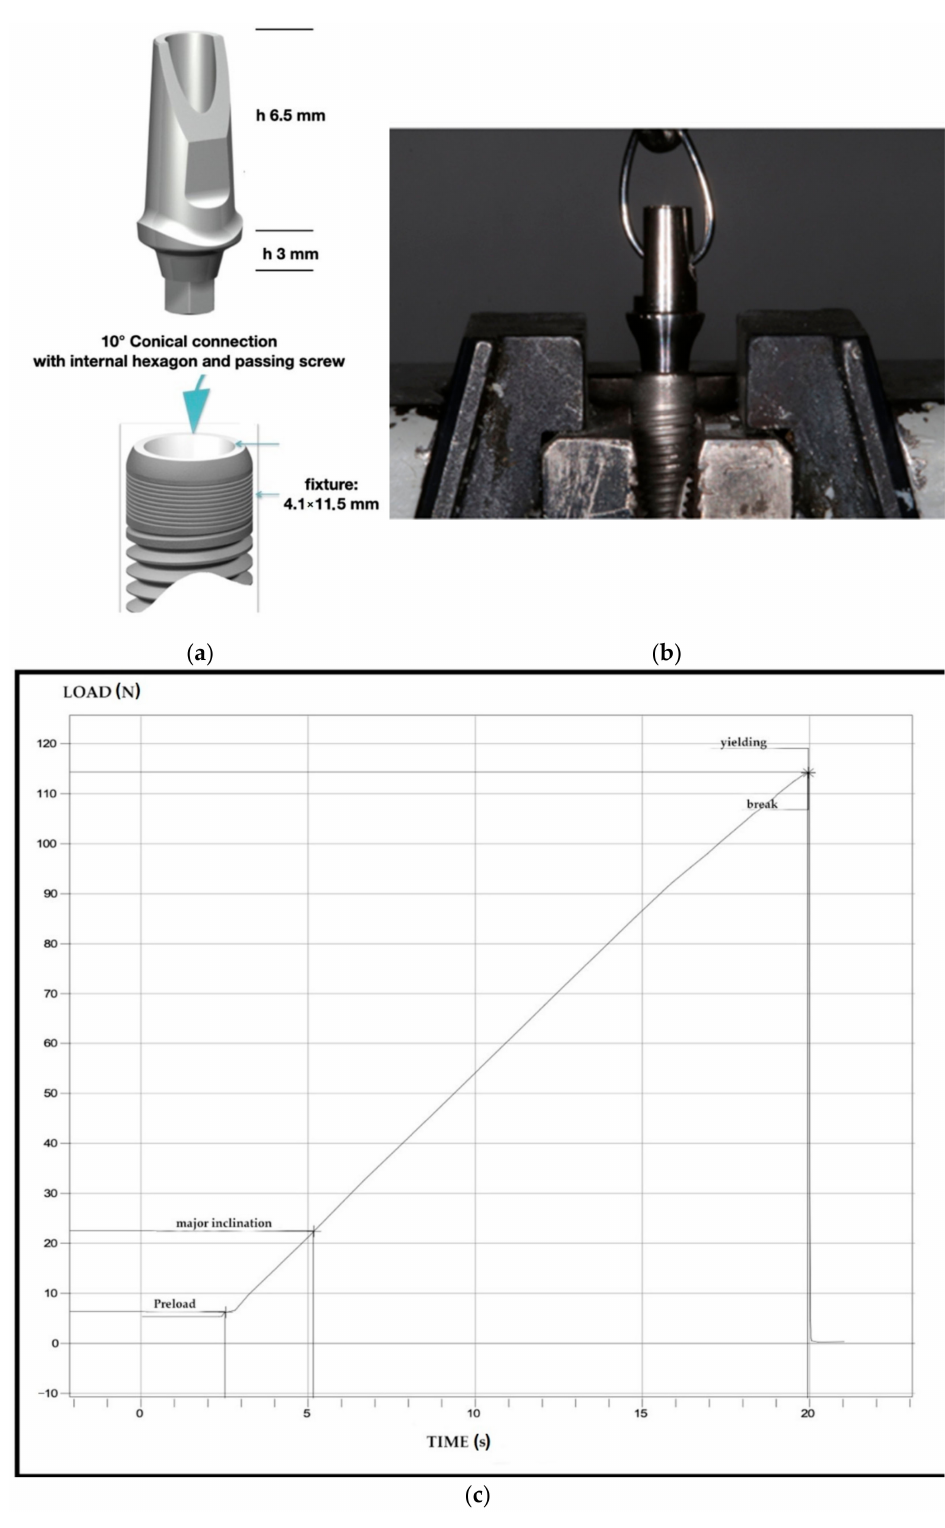
Figure 1. ( a ) Technical specific dimensions. ( b ) The fixture-abutment system fixed to the universal test machine. ( c ) Graphical representation of load-time